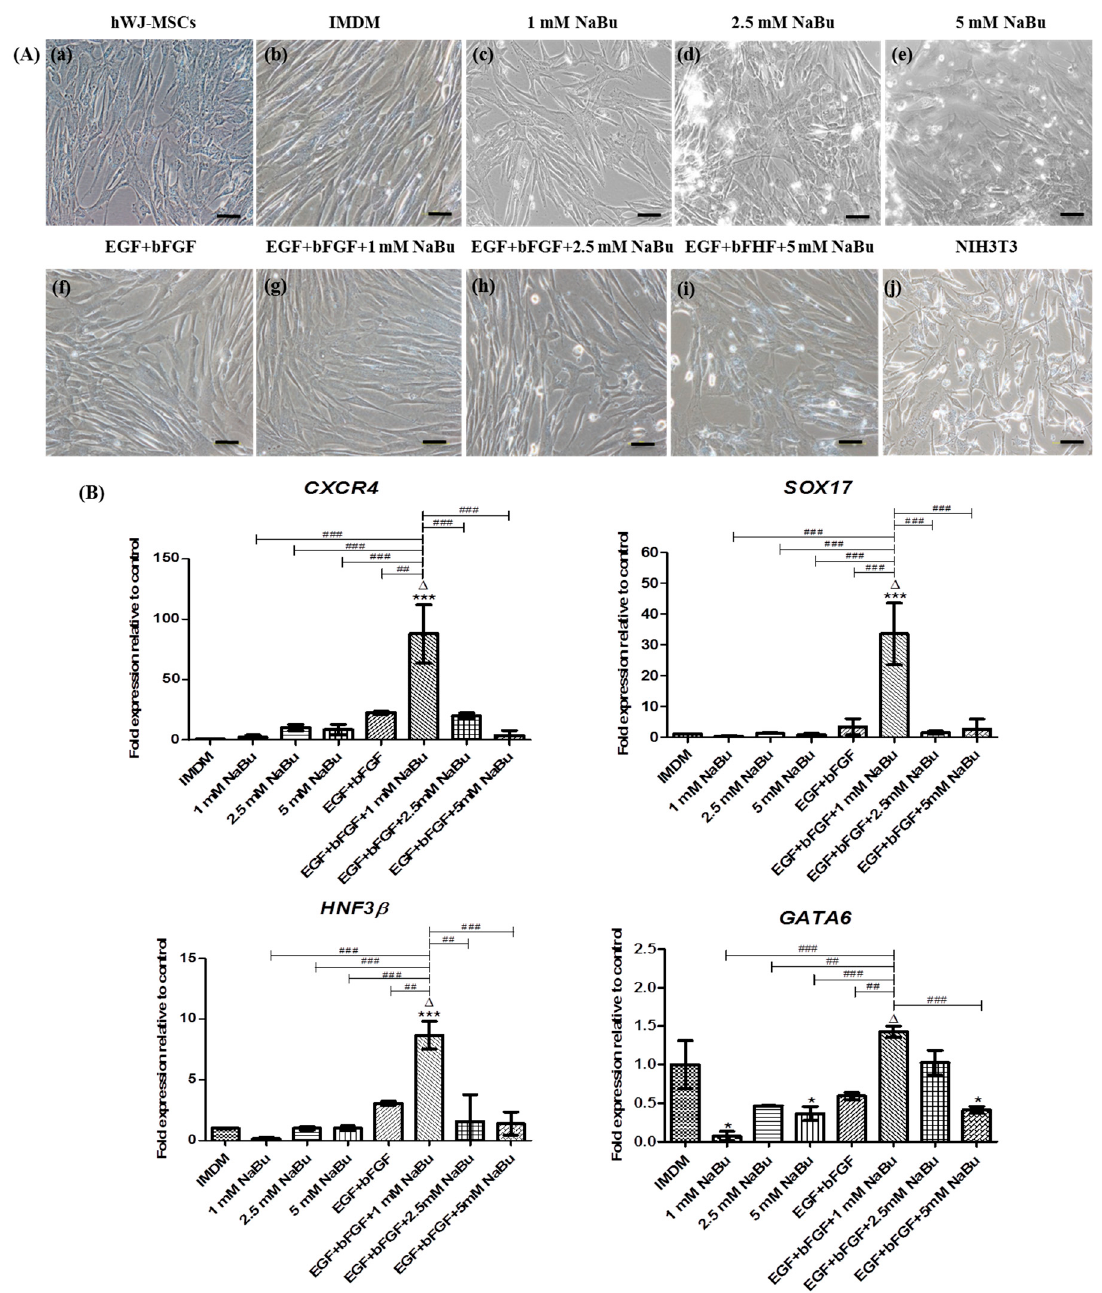
Figure 3. The morphological changes and real–time polymerase chain reaction (RT–PCR) analysis of mesendodermal and endodermal specific gene expressions of human Wharton’s jelly–derived mesenchymal stem cells (hWJ–MSCs) for 3 days of di ff erentiation. ( A ) hWJ–MSCs were cultured with 0–5 mM sodium butyrate (NaBu) with and without epidermal growth factor (EGF) and basic fibroblast growth factor (bFGF) supplementation for 3 days. Phase–contrast microscopic images of hWJ–MSCs morphology changing after exposing 0–5 mM NaBu with and without EGF and bFGF supplementation for 3 days ( b – i ). hWJ–MSCs and NIH3T3 cells were used as negative and positive control cells ( a , j ). (Original magnifications 200 × , bar = 50 µ m). ( B ) RT–PCR analysis of definitive endoderm specific gene expression of CXCR4 , SOX17 , and HNF3 β and mesendoderm specific gene expression of GATA6 after 3 days of pre–treatment. Gene expression was normalized to GAPDH and was shown as expression fold–change relative to that of control cells. The experiments were performed in triplicate. The data are shown as mean ± SD, * p < 0.05, and *** p < 0.001 compared to the control group. ∆ , represents the significantly highest mRNA expression ( p < 0.001) compared to all other groups. ## p < 0.01, and ### p < 0.001 compared to the significantly highest mRNA expression